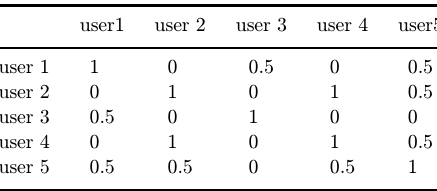
Table 3. Example of the user similarity